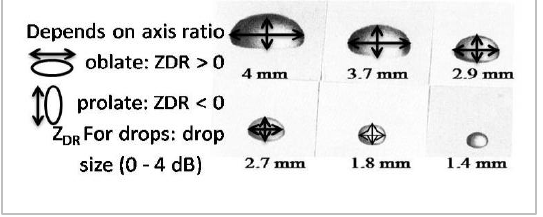
Figure 6 . The relation between and axes ratio